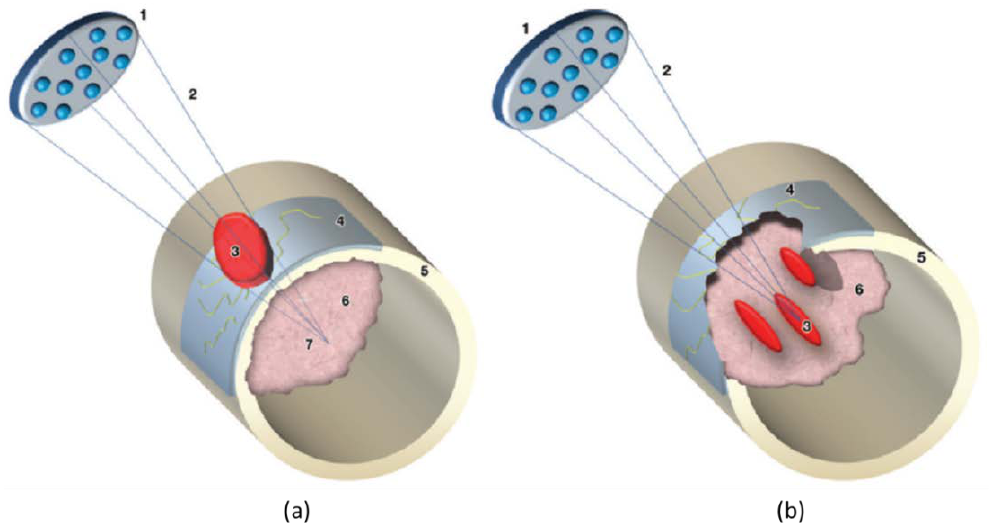
Figure 2. Diagrams illustrate the wide-beam approach used for treating bone metastases. 1 = trans- ducer, 2 = focused ultrasound beam, 3 = area of ablation, 4 = invaded periosteum, 5 = cortical bone, 6 = metastasis, 7 = acoustic focus. When cortical bone is intact, as in ( a ) the ultrasound beam is entirely absorbed by the cortex surface, even if the focus of the ultrasound beam is placed beyond the cortical line. When a bone metastasis features transcortical growth (osteolytic lesion), as in ( b ) discontinuity of the bone surface is determined and the metastatic lesion can be treated with focal spots ( b ), as in MR imaging–guided focused ultrasound treatment of a regular solid lesion. Figures are reproduced with permission from Napoli A, Anzidei M, Marincola B C et al. MR Imaging–guided Focused Ultrasound for Treatment of Bone Metastasis 1 . RadioGraphics 2013, 33, 1555–1568 [14].